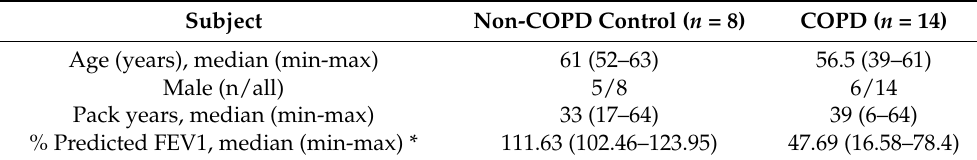
Table 2. Subject